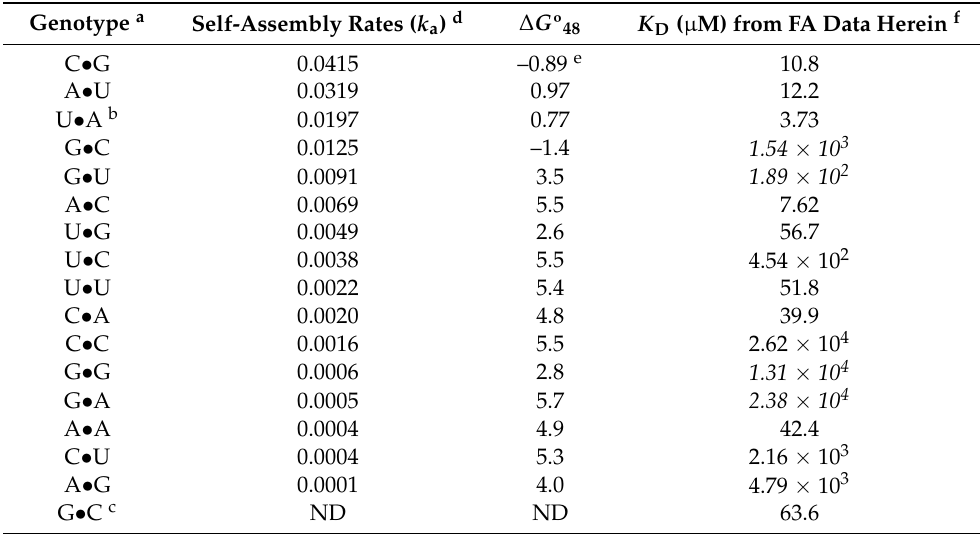
Table 1. Catalytic and duplex binding data for all 16 WXY